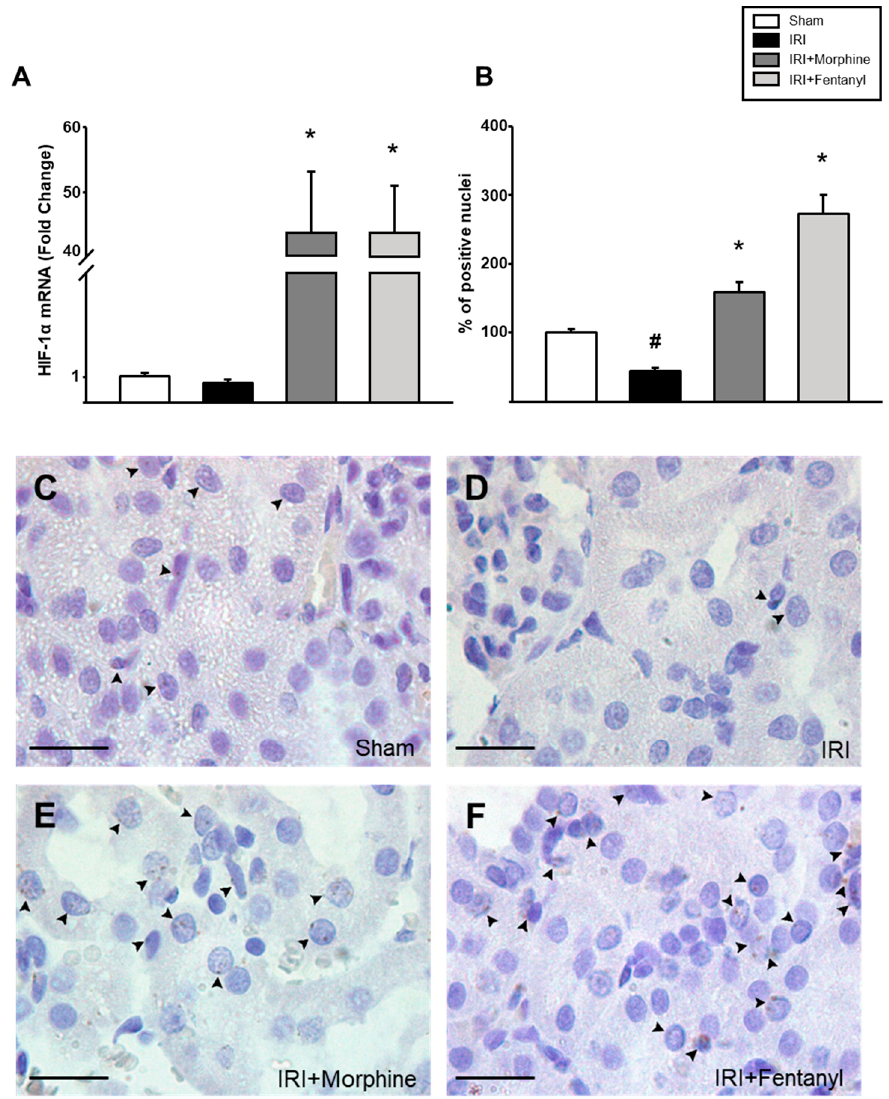
Figure 3. Opioid preconditioning promoted HIF-1 expression. ( A ) HIF-1 α mRNA expression was analyzed by real-time PCR in the ischemia-reperfusion treated kidneys. Immunohistochemistry was performed in the ischemia-reperfusion treated kidney slides and the number of positive signal nuclei was quantified at 100 × ( B ) from sham group ( C ), IRI ( D ), morphine- ( E ) and fentanyl-preconditioned animals ( F ). The average count of positive nuclei in the sham group was set as 100%. Sham group is represented by the white bars, IRI by the black bars, IRI + morphine by the dark gray bars, and IRI + fentanyl by the light gray bars. Scale bars represent 20 µ m. Values are means ± S.E.M. ( n = 6). # p < 0.05 vs. sham, * p < 0.05 vs. IRI.